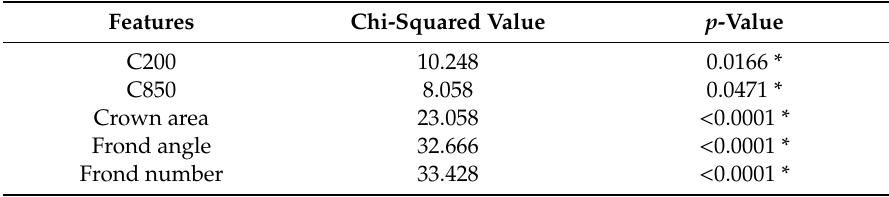
Table 11. Kruskal–Wallis test for each